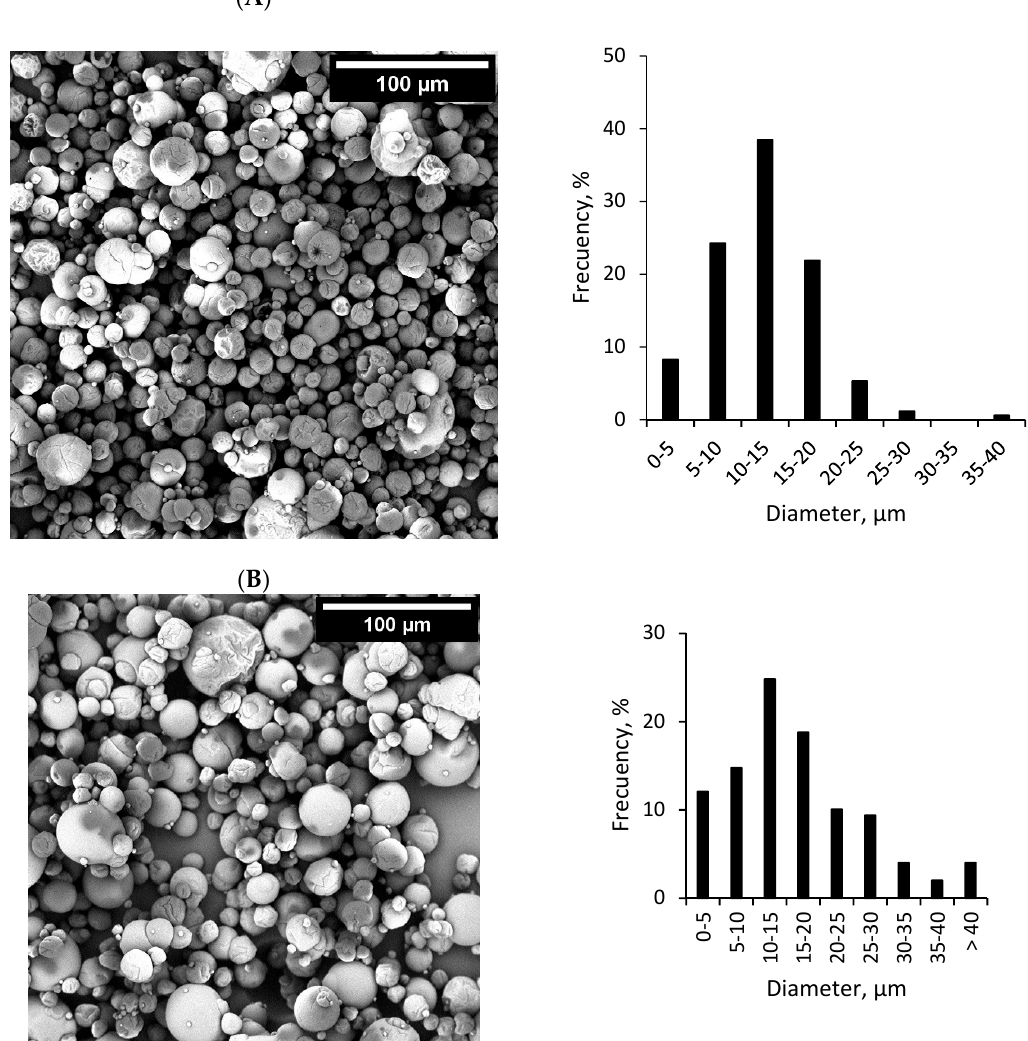
Figure 1. SEM micrographs and diameter distribution of fish oil-loaded microcapsules containing whey protein hydrolysate (WPH) as a film-forming material and glucose syrup ( A ) or maltodextrin DE21 ( B ) as the encapsulating